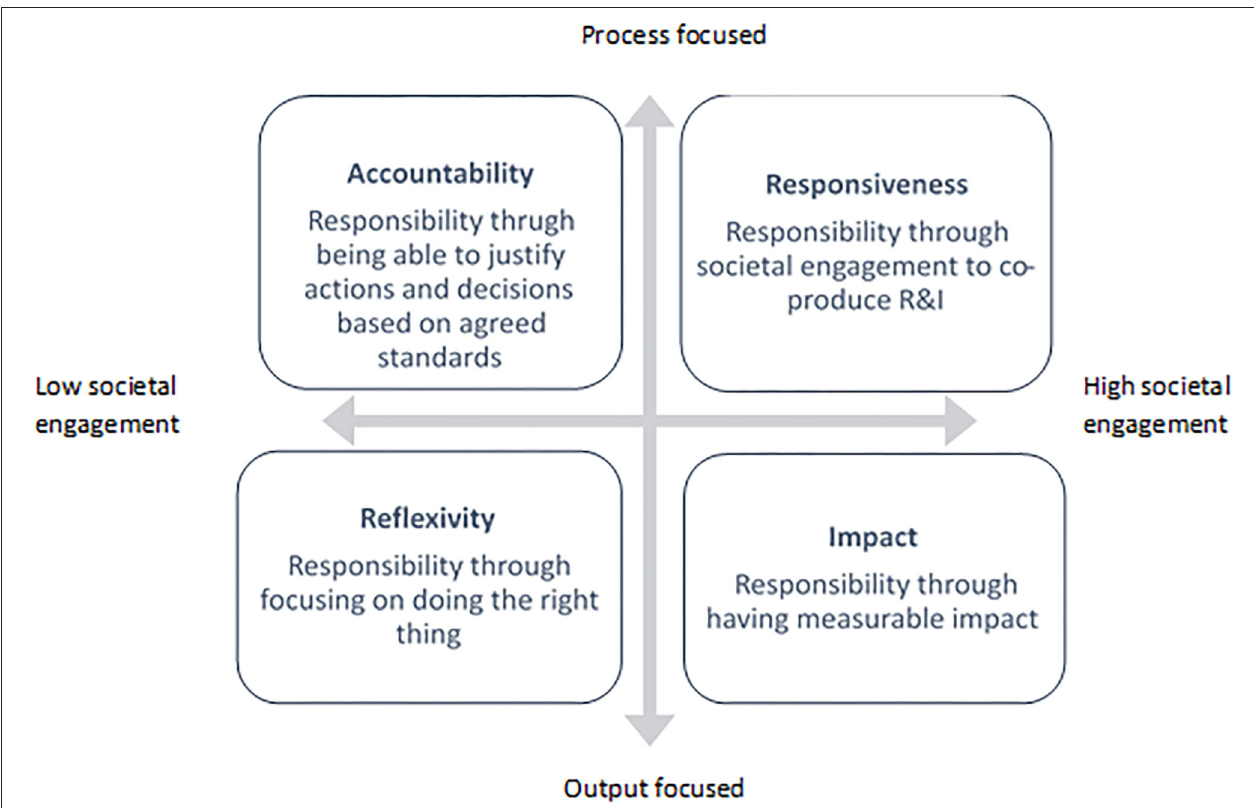
FIGURE 1 | A map of the four rationales of responsibility, describing how they vary in emphasis on process or outcome and degree of societal engagement